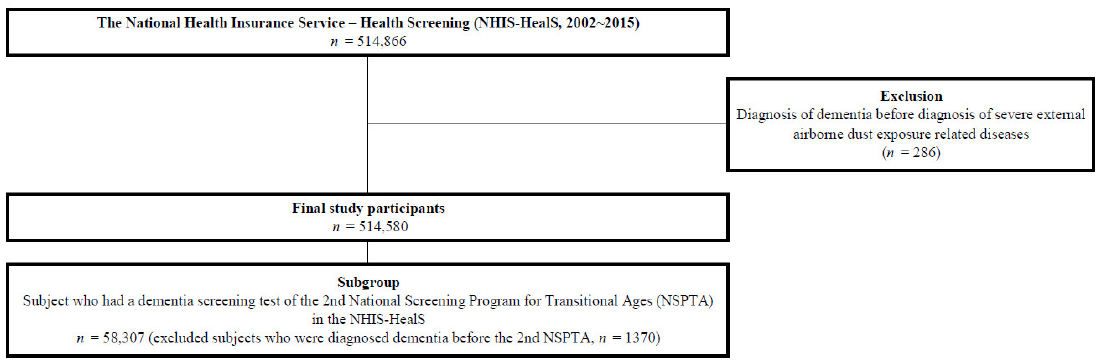
Figure 1. Schematic diagram depicting study population.